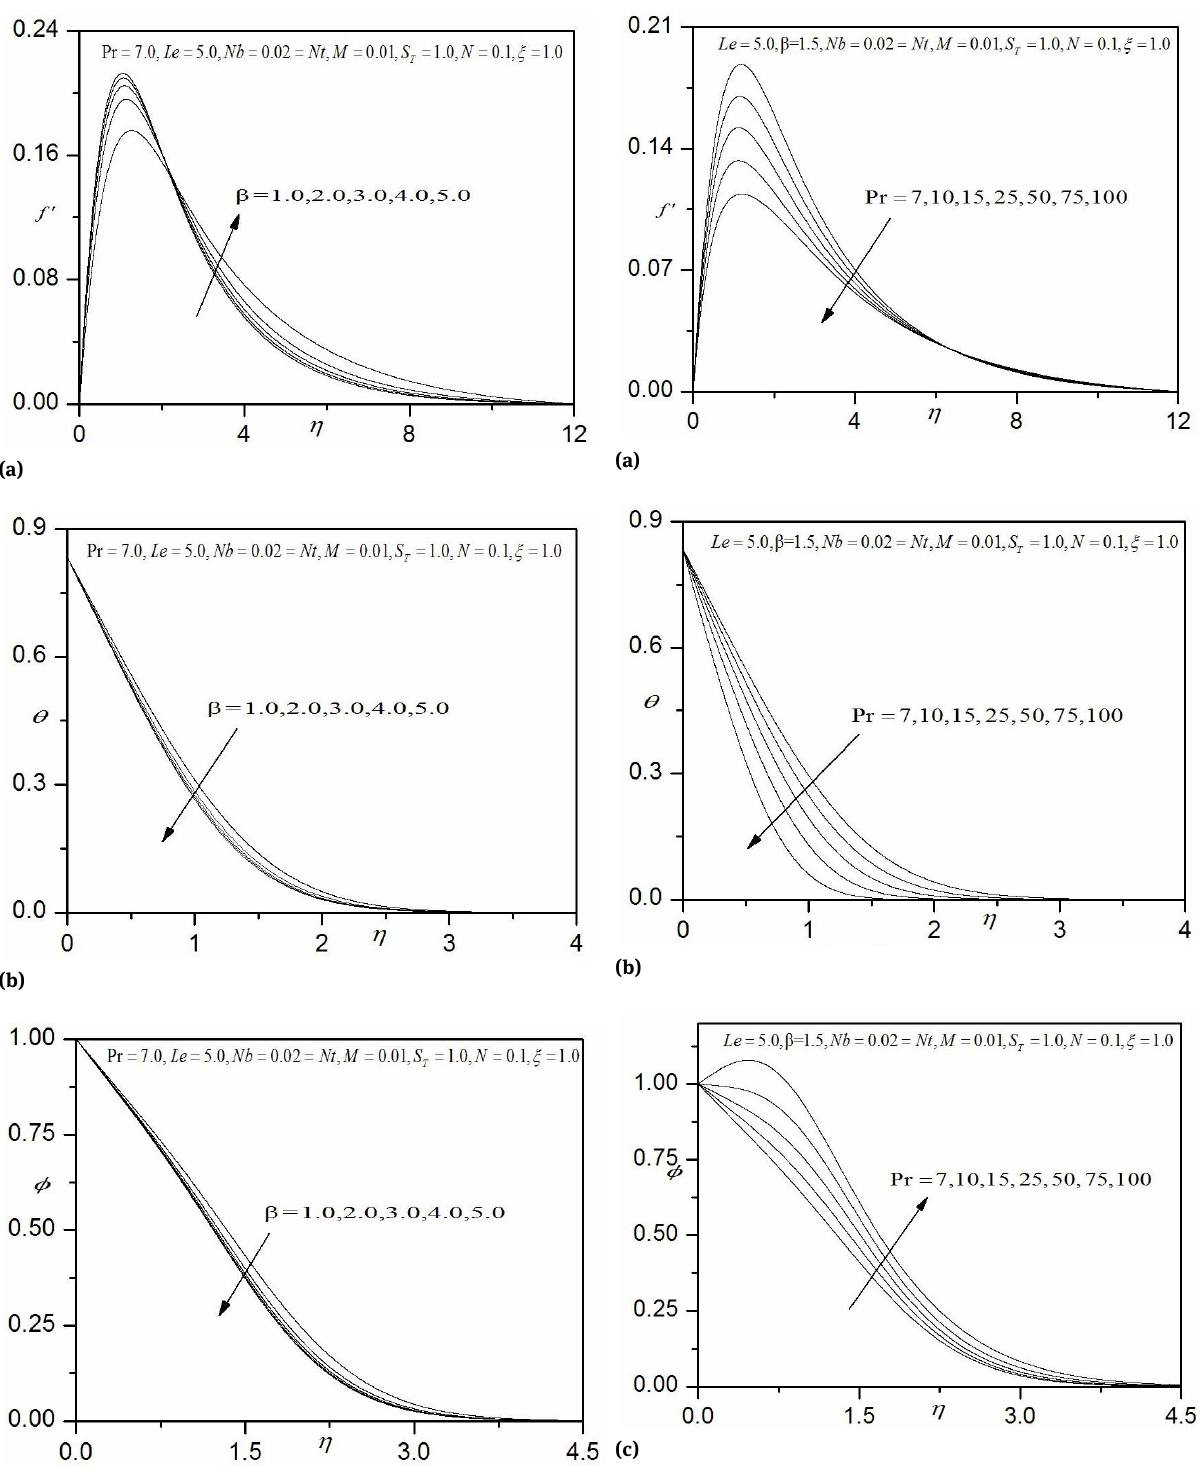
Fig. 4: Effect of Pr on (a) velocity profiles, (b) temperature